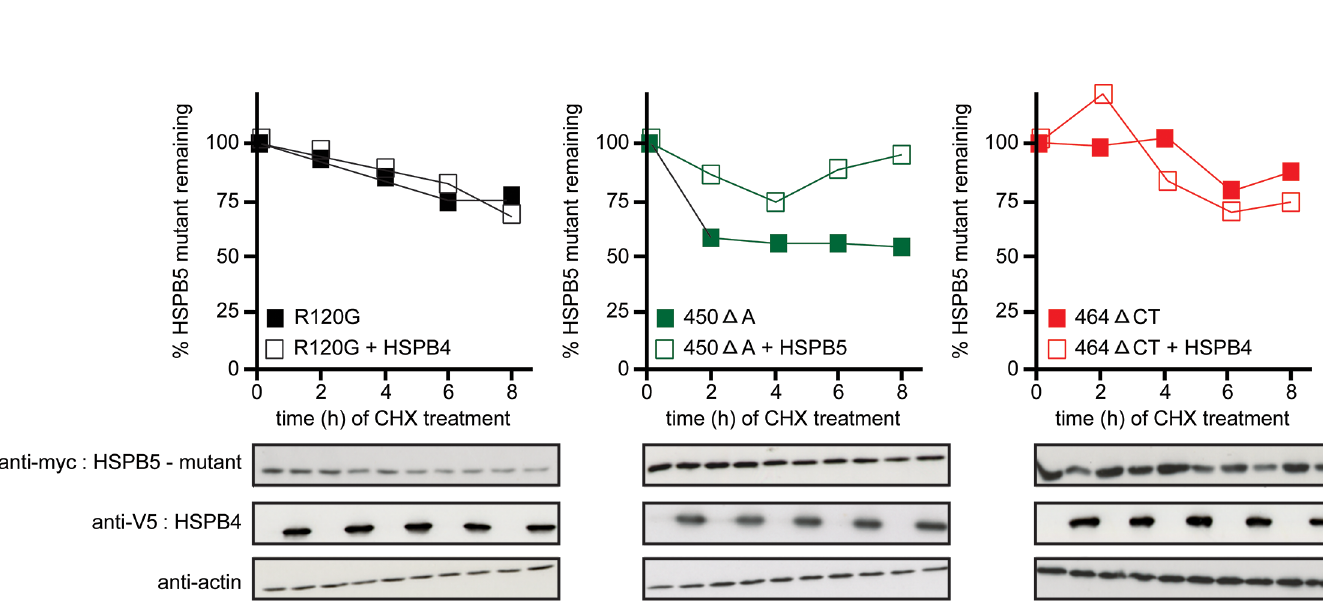
PLOS ONE | DOI:10.1371/journal.pone.0126761 May 11,